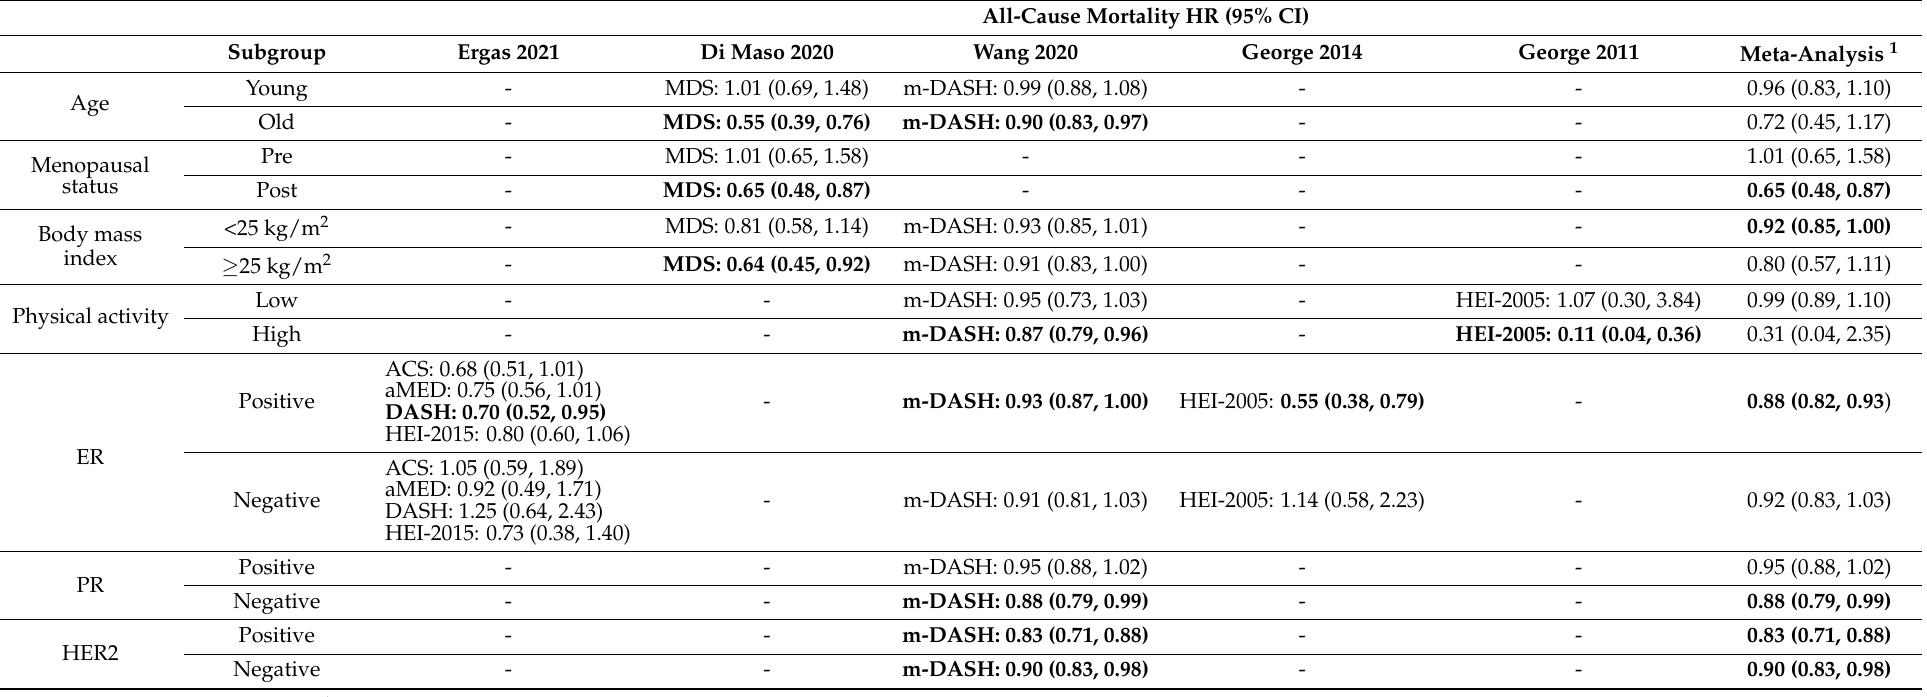
1 Results are from the random-effects model meta-analysis, and significant findings are in bold. ACS: American Cancer Society, aMED: Alternate Mediterranean Diet, AHEI: Alternative Healthy Eating Index, DASH: Dietary Approaches to Stop Hypertension, MDS: Mediterranean Diet Score, mDASH; modified Dietary Approaches to Stop Hypertension, HEI: Healthy Eating Index, HR, hazard ratio, ER: estrogen receptor, HER2: human epidermal growth factor receptor, PR: progesterone